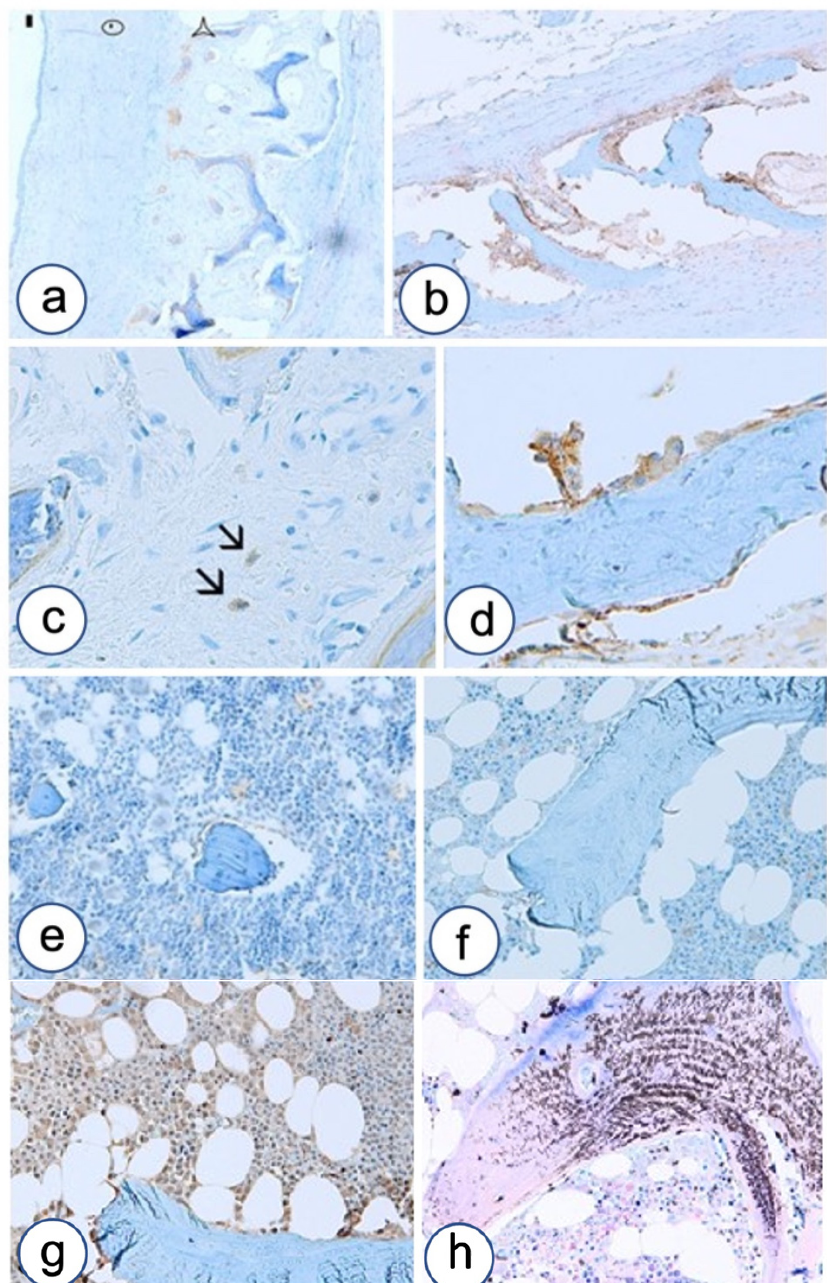
Figure 8. B-catenin, OB-cadherin, E-cadherin, N-cadherin and bone mineralization in controls of non-dysplastic bone as evaluated by immunohistochemistry and Von Kossa–Giemsa staining. ( a ) Overview showing odontogenic cyst composed of epithelial layer (rectangle), and connective wall (circle) compressing and remolding normal jaw bone (star), the latter showing OB-cadherin staining surrounding bone trabeculae. ( b ) Further details of OB-cadherin positive bone. ( c ) Precursors of OB- cadherin positive osteoblasts (arrows). ( d ) Details of OB-cadherin positive osteoblasts. ( e ) B-catenin staining in normal osteomedullar biopsy showing faint expression in medullar precursors and osteoblasts. ( f ) E-cadherin staining in normal osteomedullar biopsy showing faint expression in medullar precursors and negative staining of osteoblasts. ( g ) N-cadherin staining in normal osteomedullar biopsy showing moderate expression in medullar precursors and osteoblasts. ( h ) Control of normal bone mineralization and medullar precursors by Von Kossa–Giemsa staining. Magnifications, ×4 (a), ×10 (b,c,e,g,h), ×20 (d). 3.2.4. The Proliferative Index The proliferative index was proven as rather inconsistent, except in some FD cases characterized by high cellularity in which ki-67 staining showed focal staining (data not